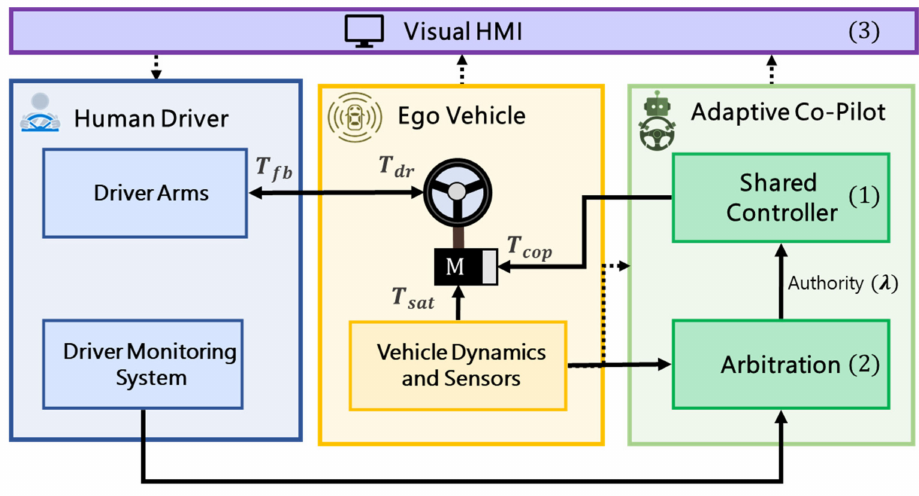
Figure 1. Adaptive co-pilot